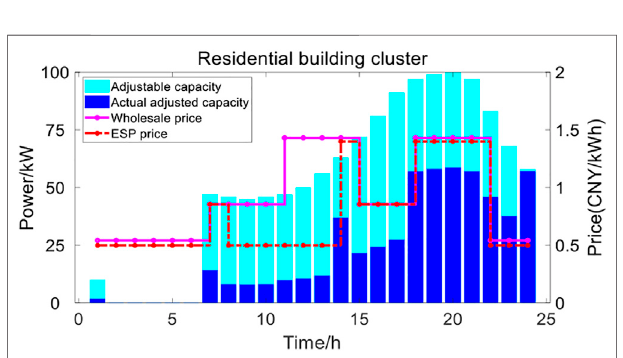
FIGURE 8 | Pricing decision-making results of residential building cluster.